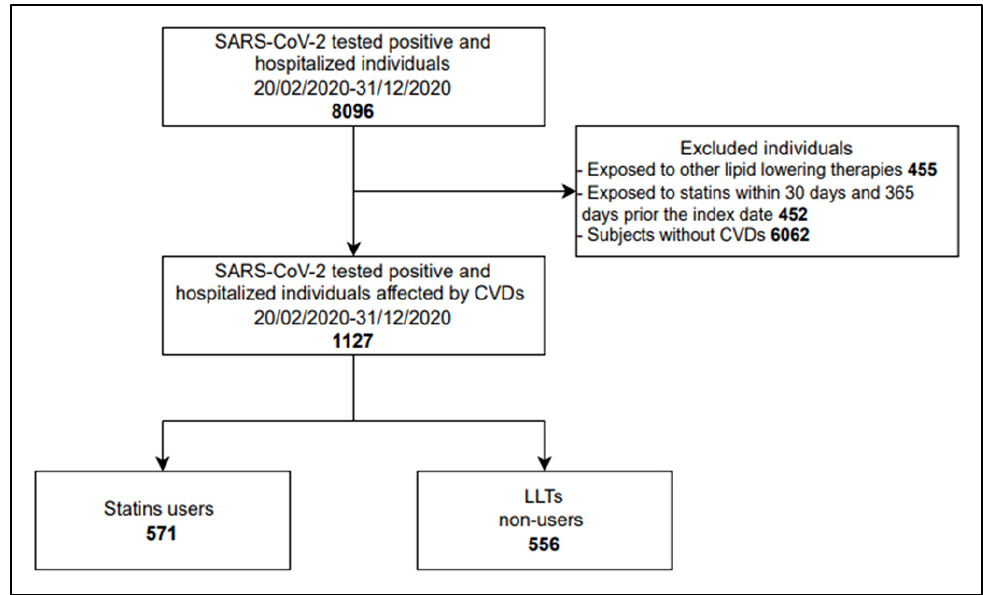
Figure 1. Study cohorts’ selection. LLTs: Lipid-lowering therapies. The demographic and clinical characteristics of the study population were reported in Table 1. Among the statins users, atorvastatin was the most prescribed (60.4%) medication,